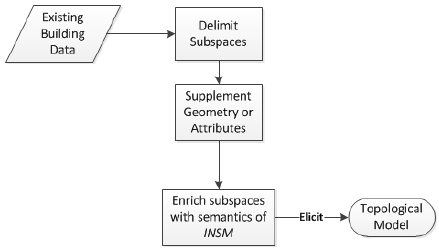
Figure 1. Workflow of generating topological